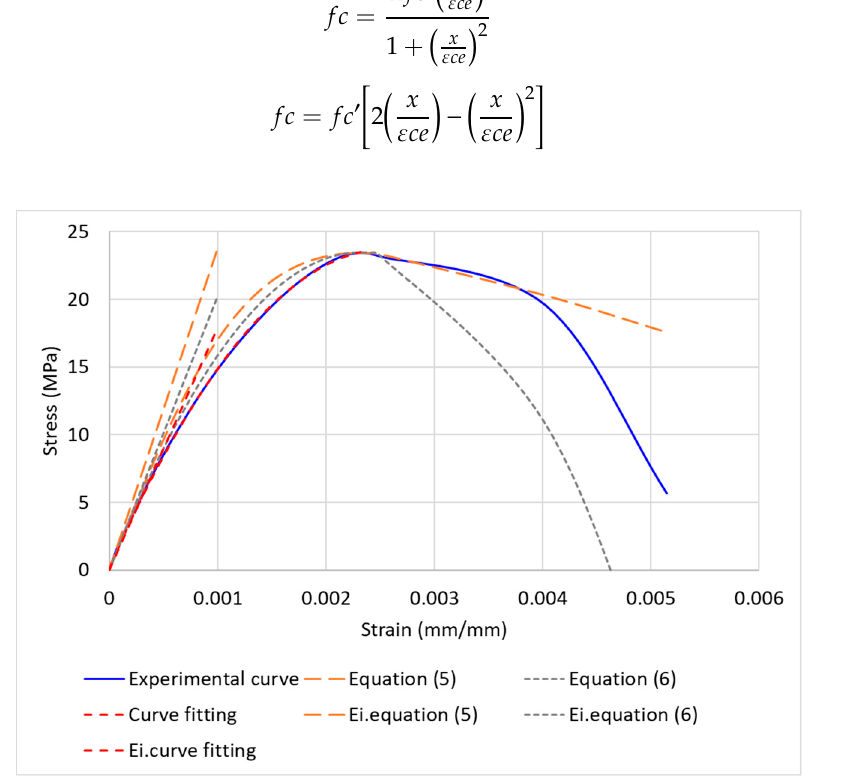
Figure 4. Extraction of initial chord elastic modulus ( Ei ) from stress-strain curve.